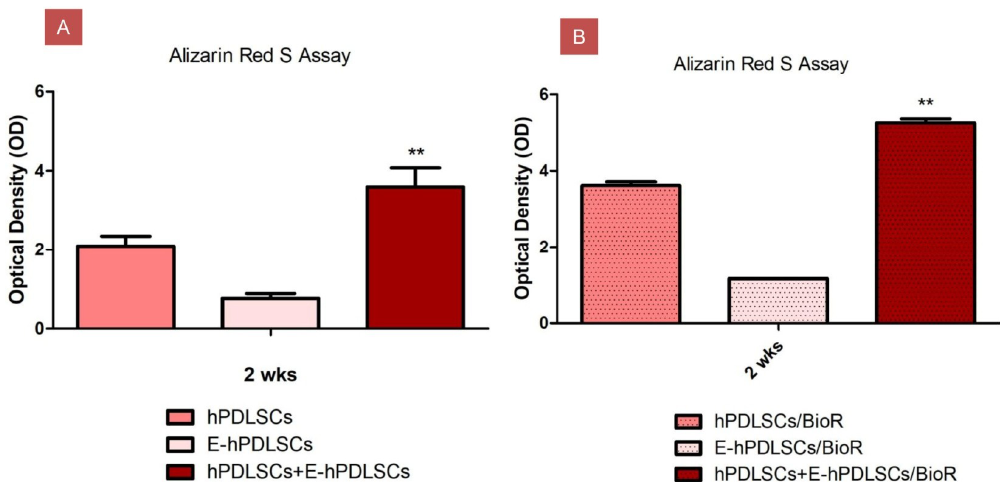
Figure 5. Osteogenic di ff erentiation detection. Alizarin Red S assay. Bar chart of the quantification of Alizarin Red S staining read at spectrophotometer. ( A ) Colorimetric assay to detect the osteogenic di ff erentiation of cells; ( B ) Colorimetric assay to detect the osteogenic di ff erentiation of cells cultured with BioR; ** p < 0.01.